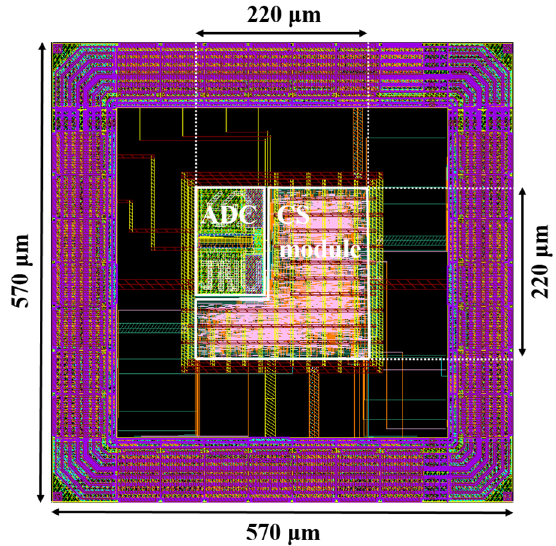
Figure 12. The layout of the sampling and compression circuit.